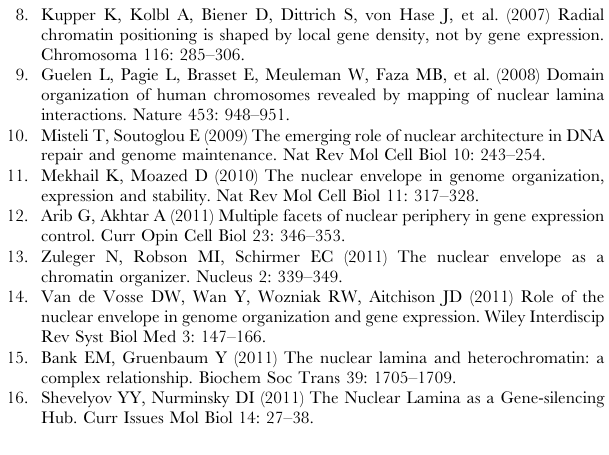
Table S1 Monte Carlo simulations results: CNPs. (PDF) Table S2 Monte Carlo simulations results: gene order- disrupting chromosome rearrangement breakpoints per ovary- and testis-specific genes. Table S3 Monte Carlo simulations results: ovary- and testis-specific genes in OL gene classes depending on the changes in their flanking genes in the Drosophila genus. Table S4 Size of Drosophila Lam OLs and D. melano- gaster testis-specific gene clusters. Dataset S1 Number of CNPs per OL. Dataset S2 Number of gene order-disrupting chromo- some rearrangement breakpoints, classification accord- ing to changes in their flanking genes, and D.